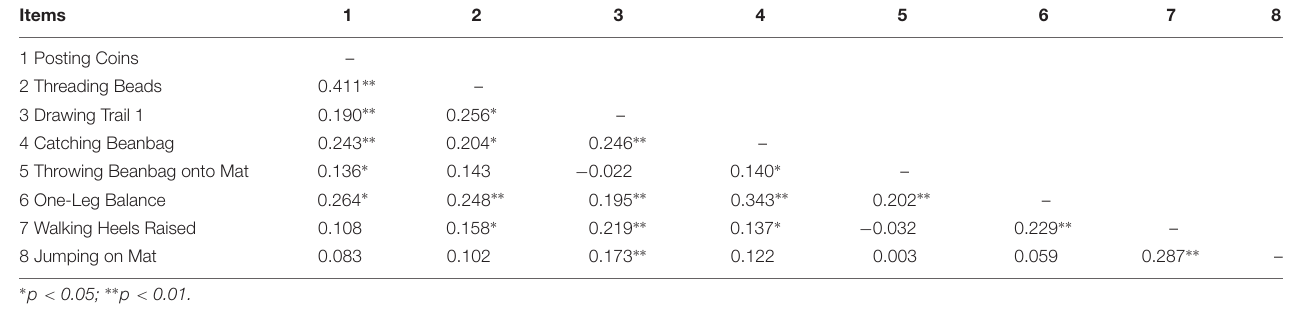
TABLE 3 | Correlation matrices of the scaled scores.